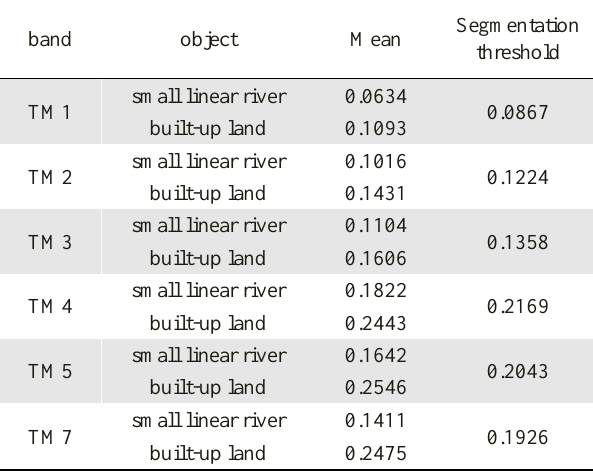
Table 1 Segmentation threshold calculated by the two types of object samples from each band.